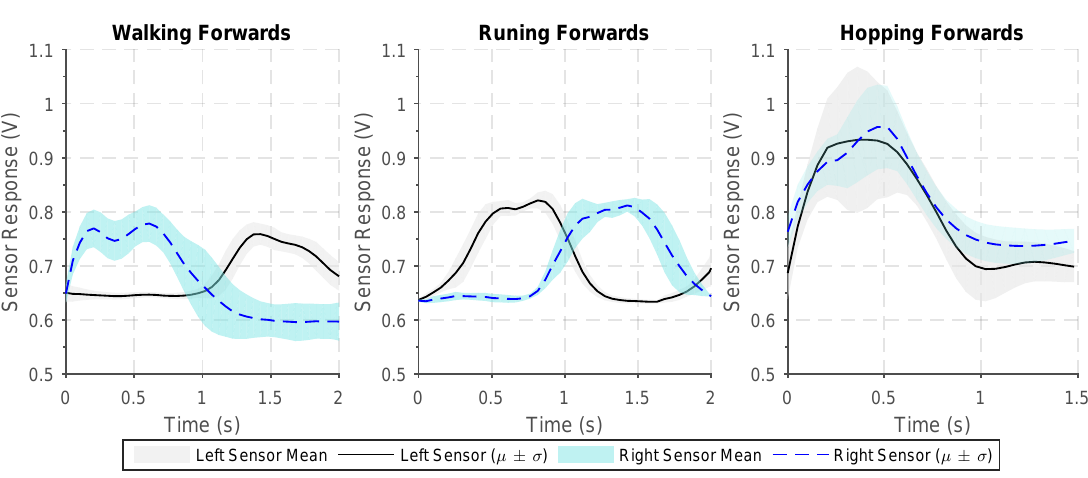
Figure 10. Average sensor output for a single period from two calf strain sensors worn when undertaking various gait types: walking forwards in a straight line, running forwards, hopping forwards.